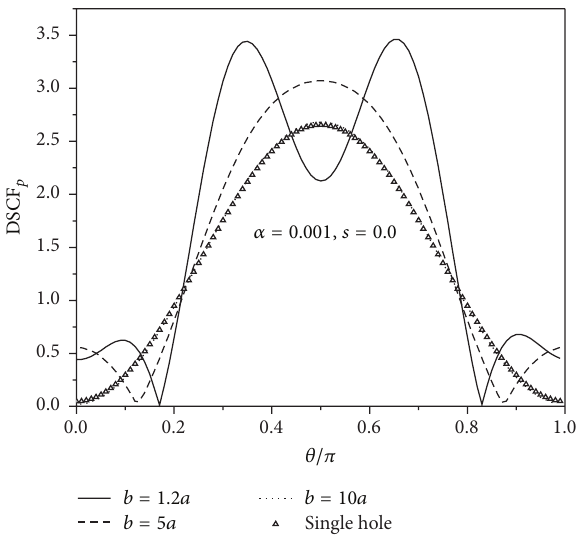
Figure 5: Distribution of DSCF along the middle hole for different separation of 𝑏 for 𝛼 = 0.001 and 𝑠 = 0 .